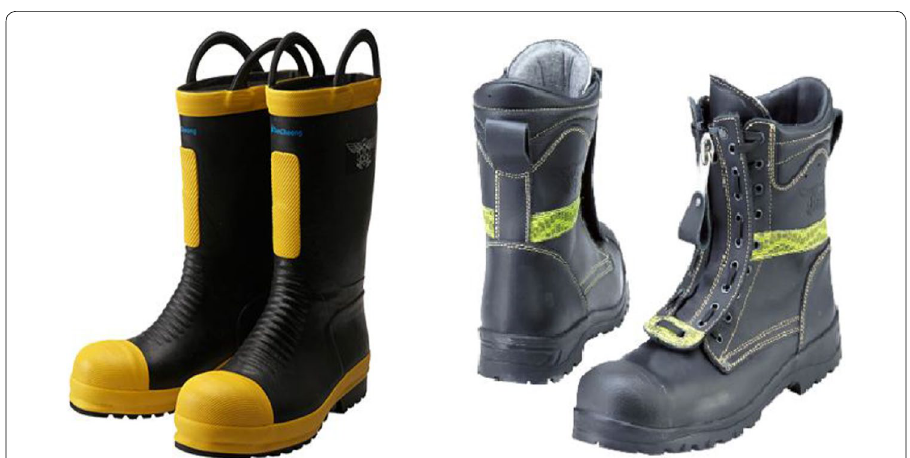
Fig. 1 Protective footwear for firefighters in